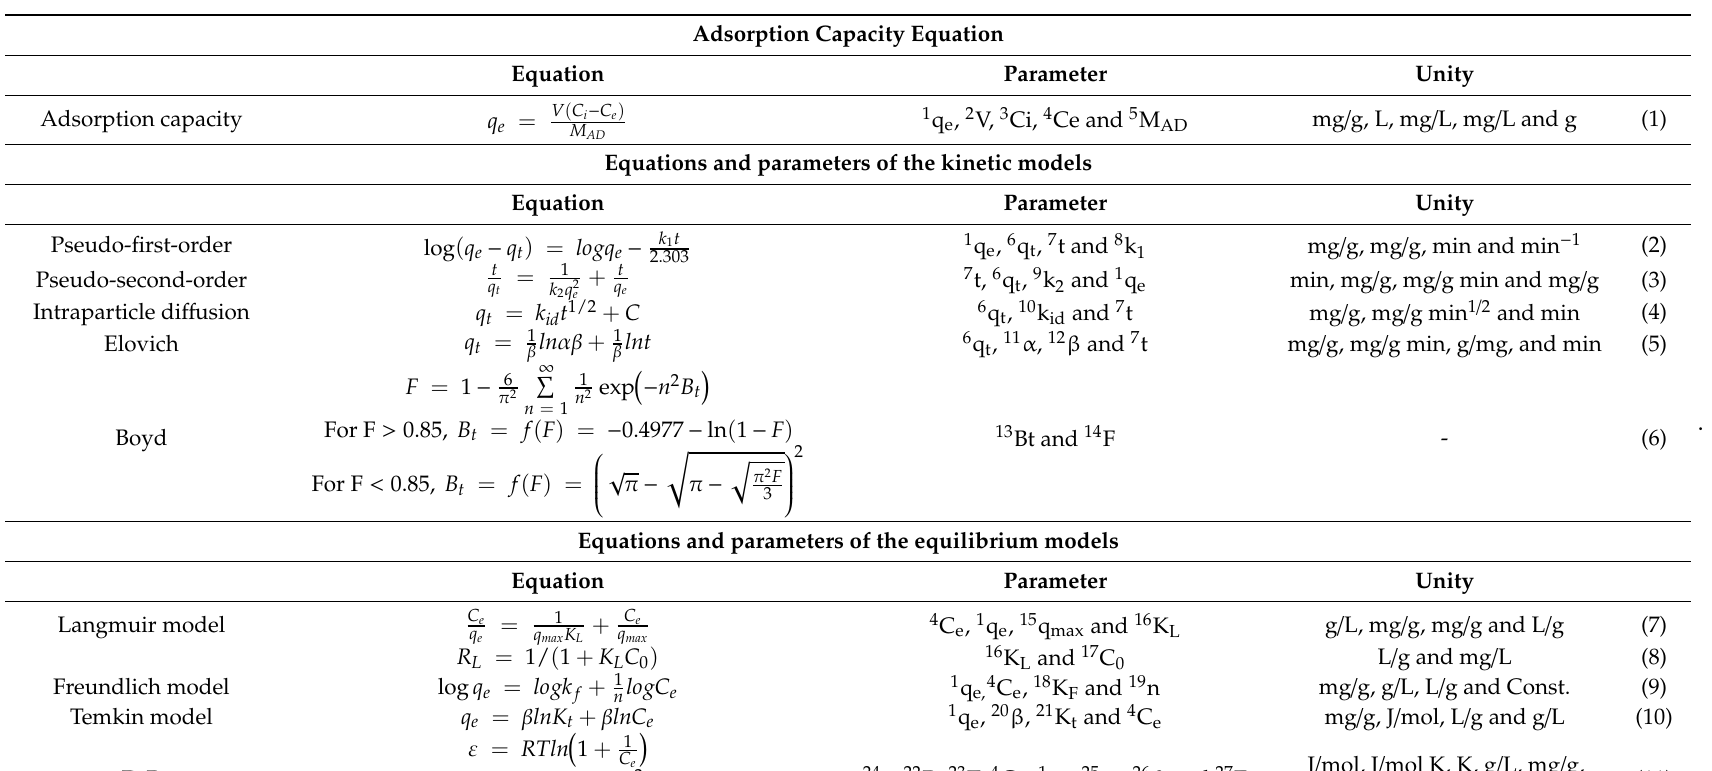
Table 5. Mathematical equations and